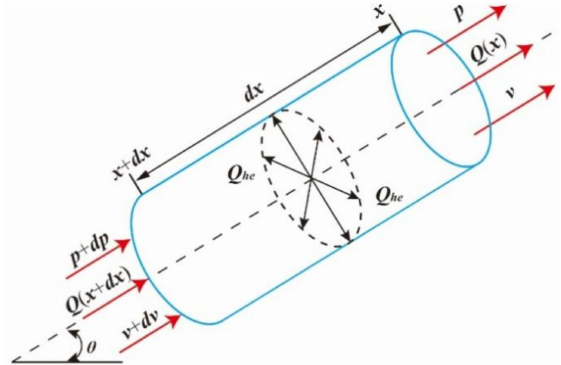
Figure 2. Analysis model of temperature and